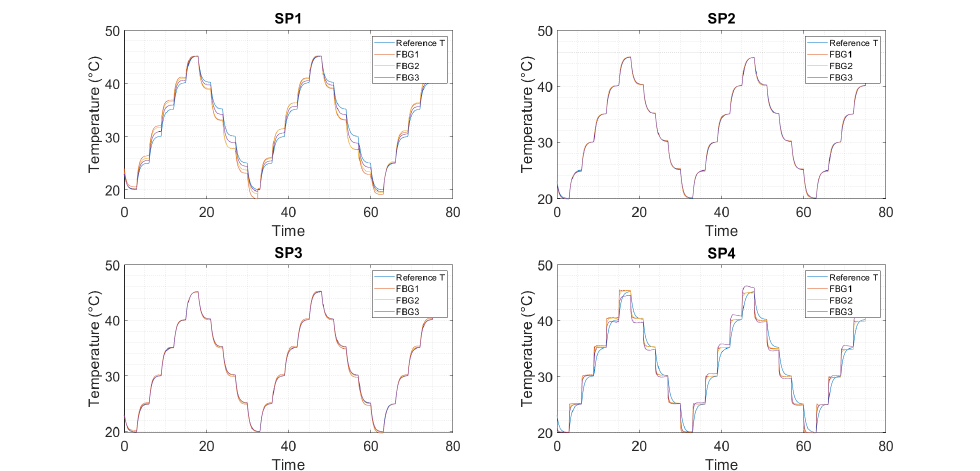
Figure 5. Standard calibration in air, all sensors. Temperature calculation with the polynomial fit from Figure 4/ Table A2. SP1: optical fiber in PEEK capillary, single-point mounting; SP2: optical fiber in fused silica tube with polyimide coating, single-point mounting; SP3: optical fiber in fused silica tube, removed polyimide coating, single-point mounting; SP4: optical fiber in fused silica tube, removed polyimide coating, double-point